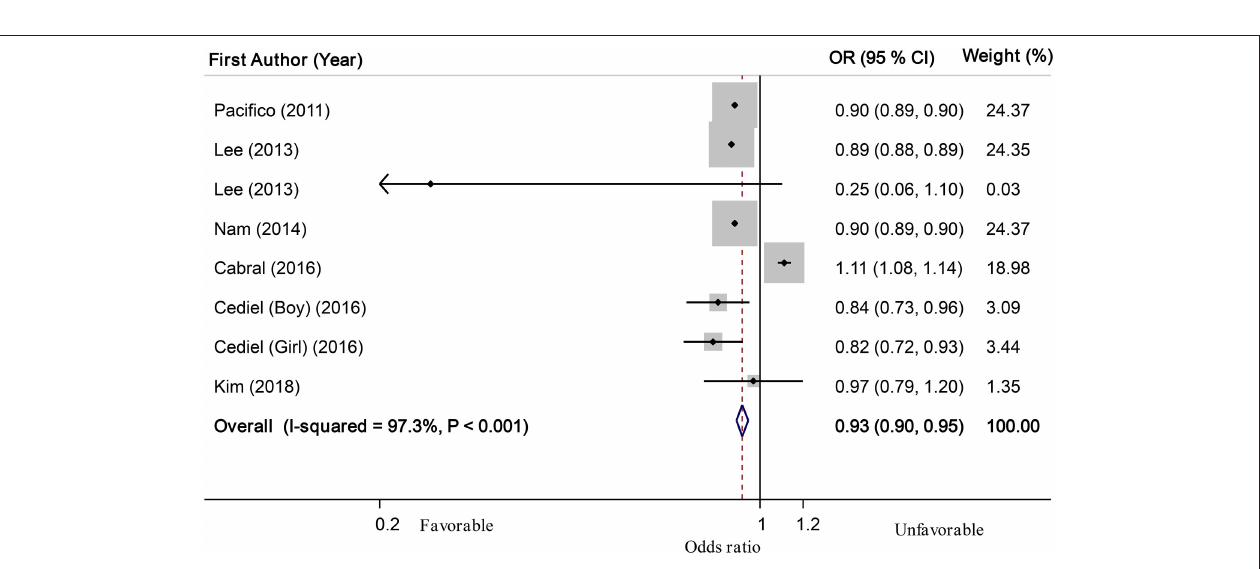
FIGURE 4 | Linear dose-response meta-analysis of the relationship between each 10ng/ml (25 nmol/L) increment in serum 25(OH) D levels and abdominal obesity in children and adolescents among studies that used waist circumference percentiles to define abdominal obesity.